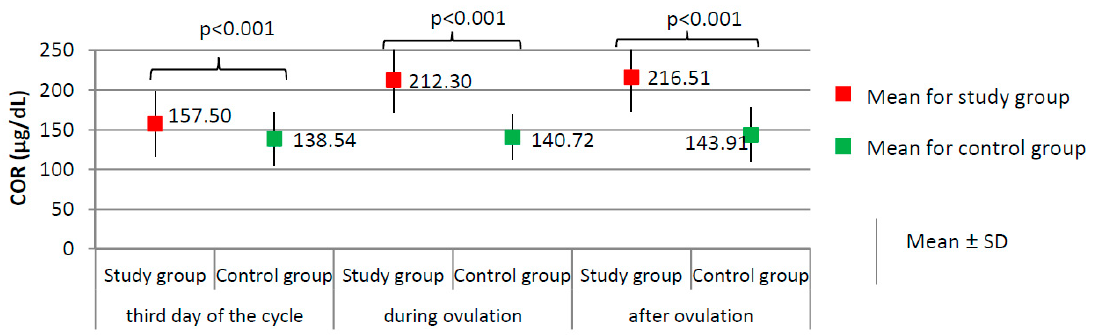
Figure 2. Comparison of COR (cortisol) between the study group ( N = 205) and the control group ( N = 100).